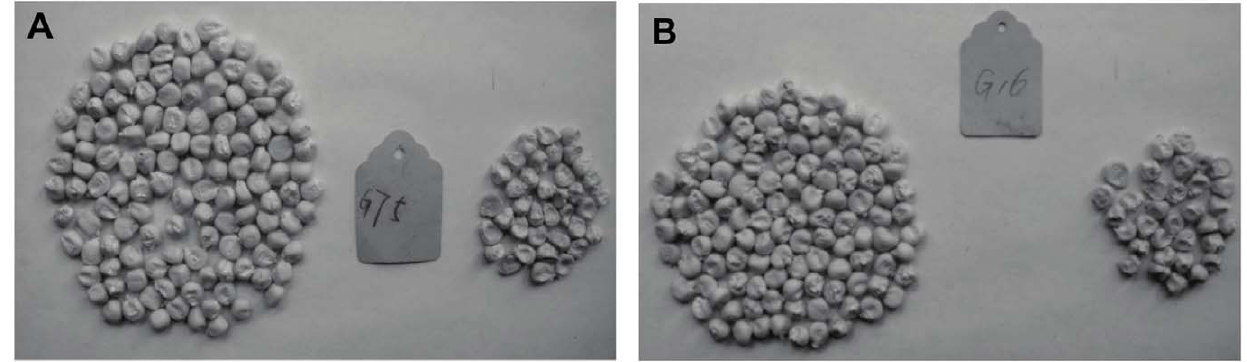
Figure 3. Smooth and shrunken seeds of 2 family lines in BC 2 F 3 . (A) phenotype of BC 2 F 3 seeds from BC 2 F 2 plant with the genotype wxwxo16o16O2o2 (G75); (B) phenotype of BC 2 F 3 seeds from BC 2 F 2 plant with the genotype wxwxo16o16O2o2 (G16).